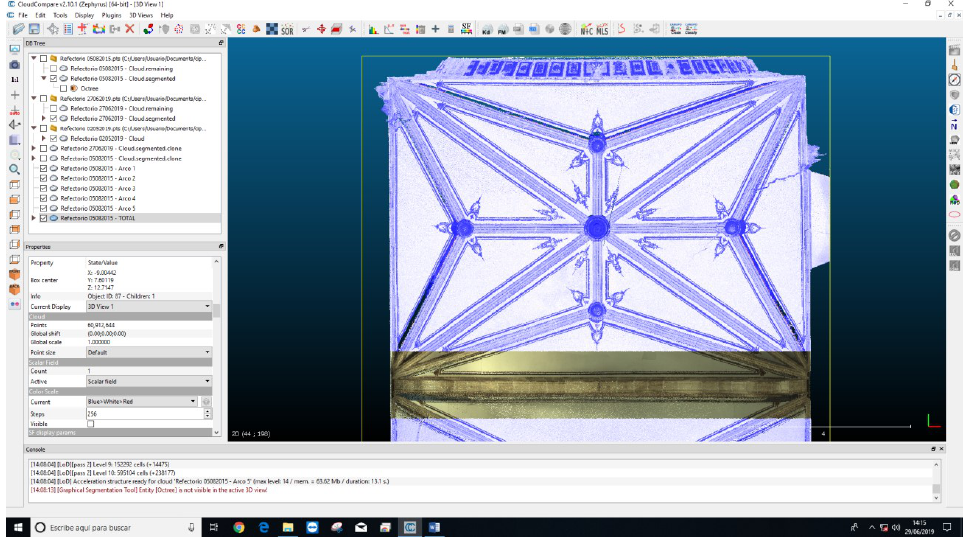
Figure 6. Strip corresponding to one arches studied with CloudCompare V2.10.1 software.